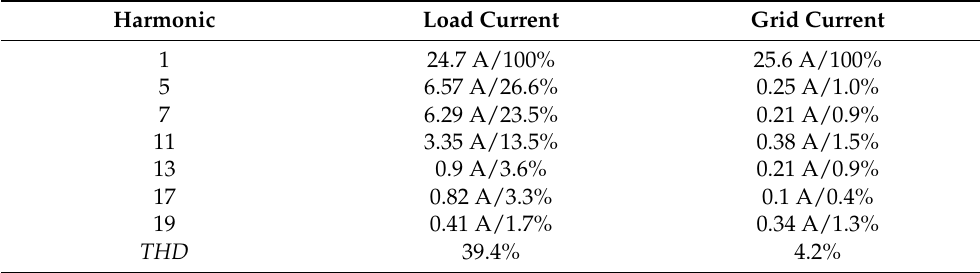
Figure 20. Operation of HAPF with the load Ld3: ( a ) the grid current, the load current and the power converter voltage waveforms; ( b ) harmonic spectrum of the grid and the load currents. Table 5. Comparison of the load currents and the grid currents for HAPF with the load Ld3.